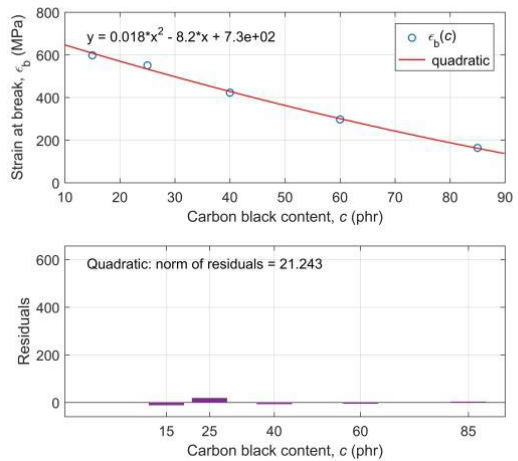
Figure 4. Regression analysis of the experimental dependence of the tensile strain at break ε b on the carbon black content c in the rubber blend (top plot); Residuals of parametric fitting of the experimental data ε b ( c ) with the estimation of goodness-of-fit (lower plot).